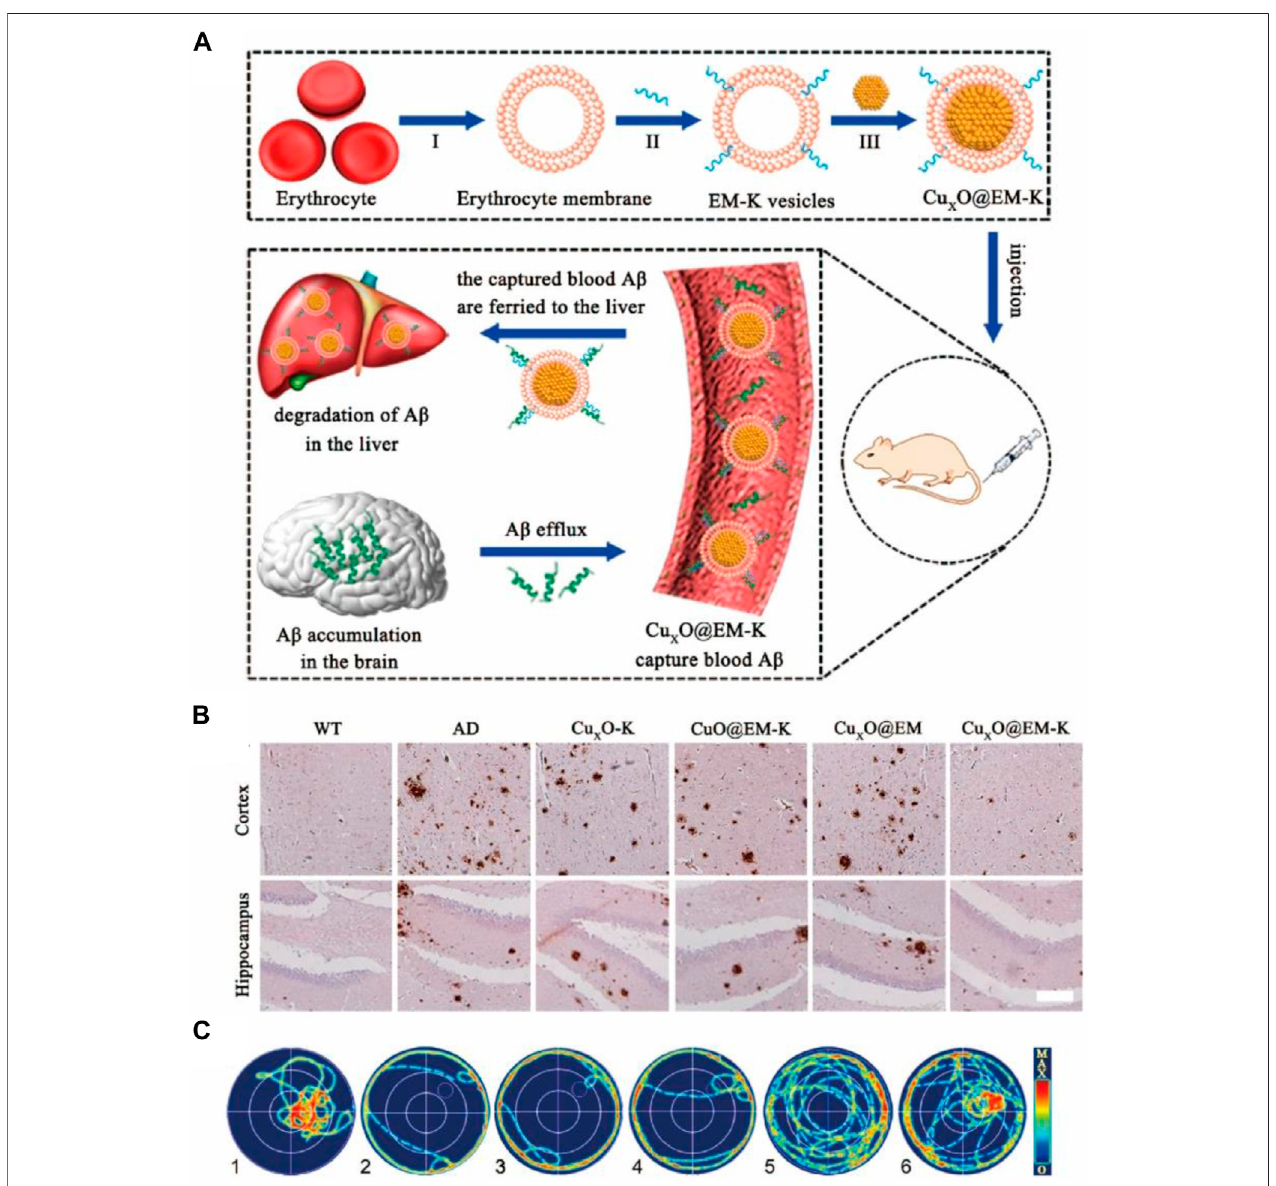
FIGURE5|(A) PreparationofCuxOnanozymewrappedwitherythrocytemembrane(CuxO@EM-K).TheresultingCuxO@EM-KcapturesA β inthebloodfollowed by elimination of A β bound to CuxO@EM-K by the liver, facilitating ef fl ux of A β from the brain into blood through the sink effect and leading to the reduction A β burden in brain. (B) Representative images of A β staining in both the cortex and the hippocampus. Scale bar: 100 μ m. (C) Representative swimming paths of mice in the probe test. Reproduced from Ma et al. (2020) with permission from the American Chemical Society.